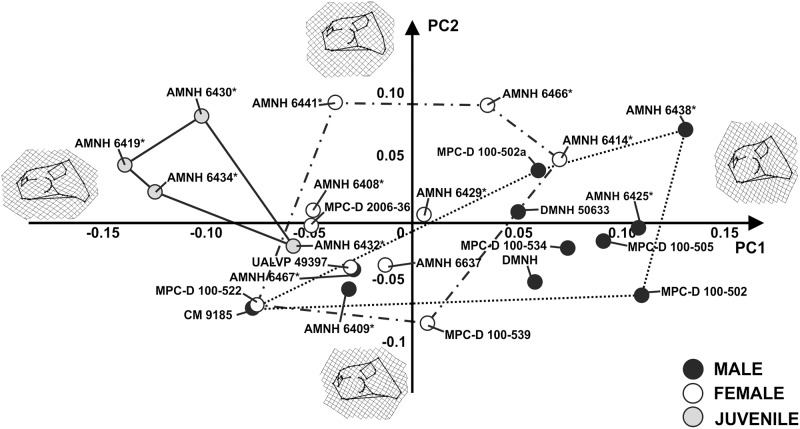
Principal Component Analysis performed on skulls with the frill excluded.The continuous line represents “juvenile” morphospace. The dotted line represents “male” morphospace and the dashed line represents “female” morphospace. Asterisks indicate specimens shared with Dodson [25].